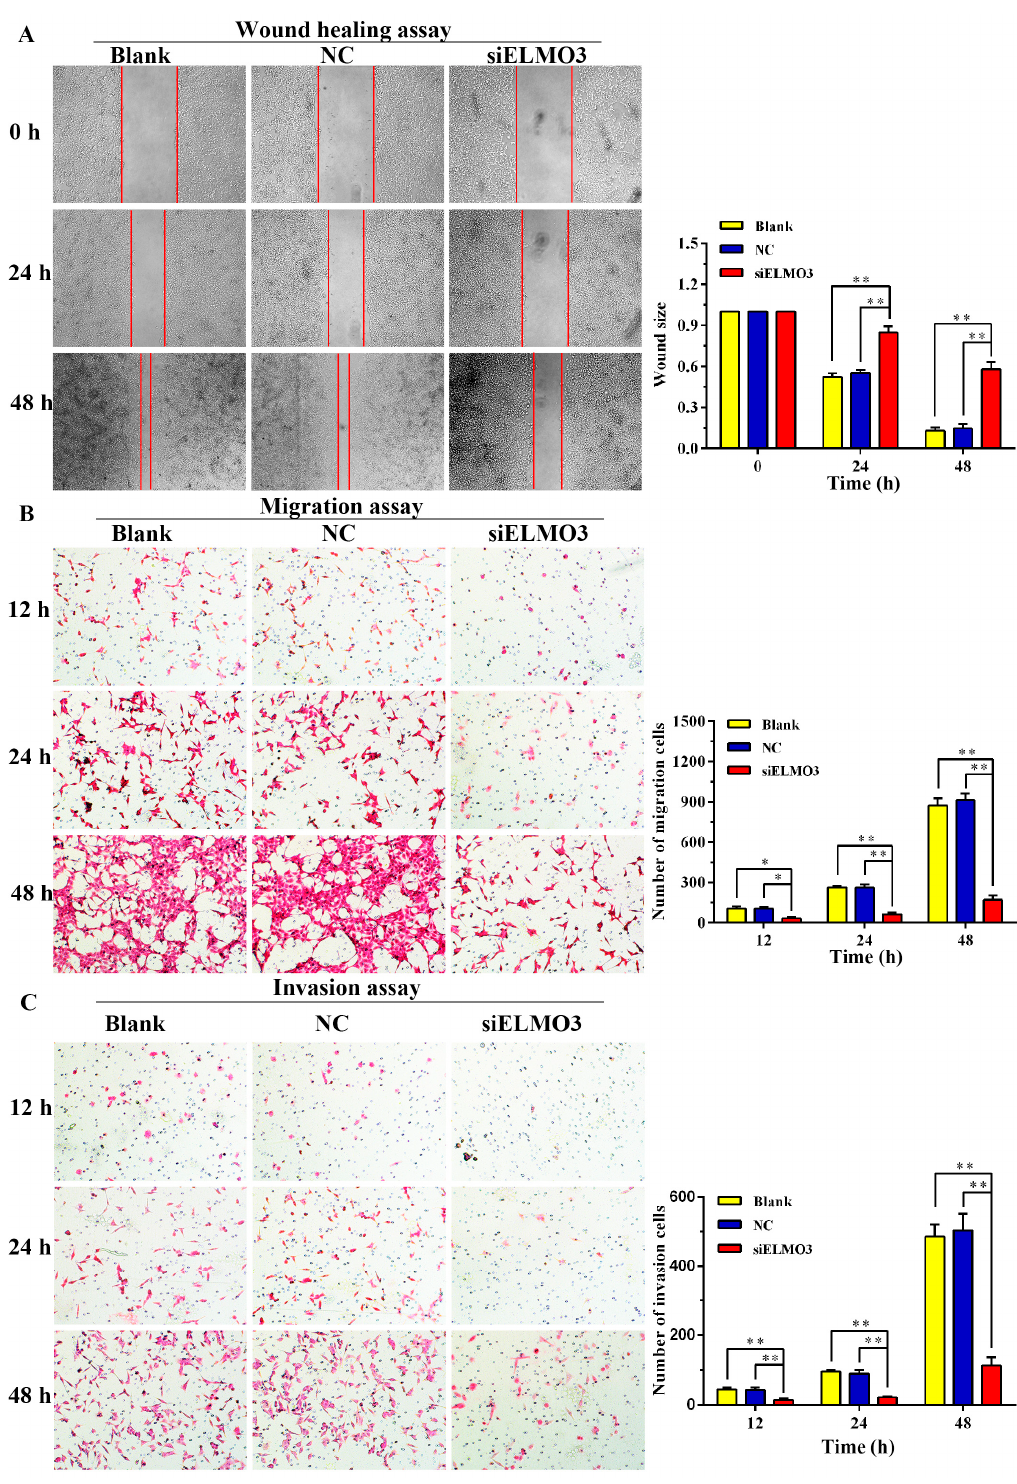
Figure 5. Knockdown of ELMO3 inhibited the migration and invasion of HCT116 cells. ( A ) The wound healing assay was carried out to examine the cell motility rates; ( B ) The Transwell assay was performed to assess cell migration potential; and ( C ) The matrigel Transwell assay was performed to assess cell invasion potential. The representative photographs are shown at 40× magnification. The statistical analysis was performed using ANOVA. * p < 0.05, ** p < 0.01.